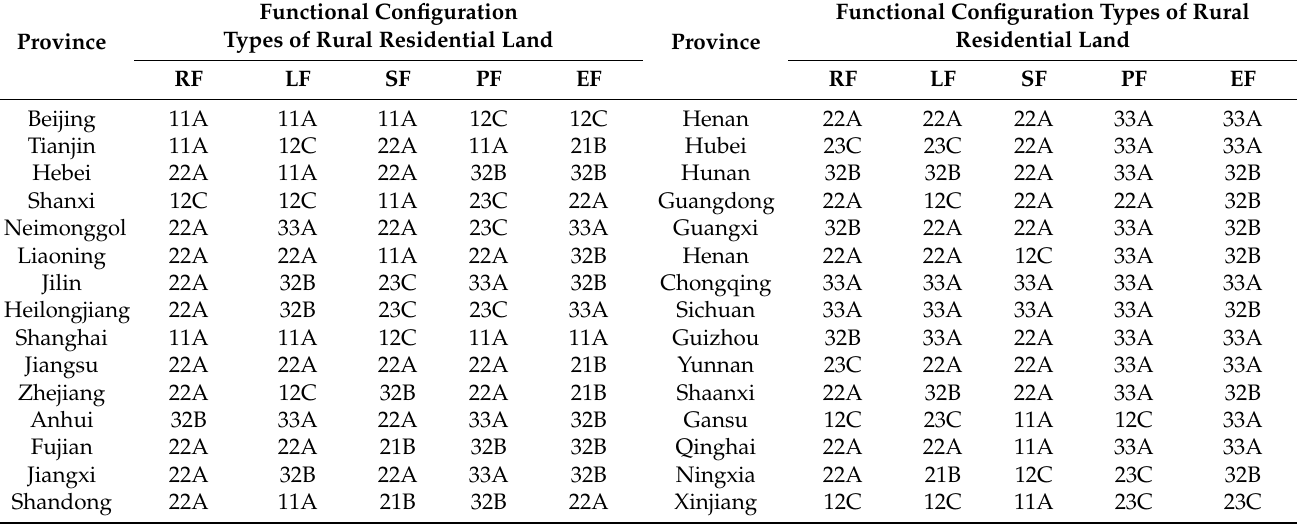
Table 4. Types and optimization levels of various functions of rural residential land in different provinces of